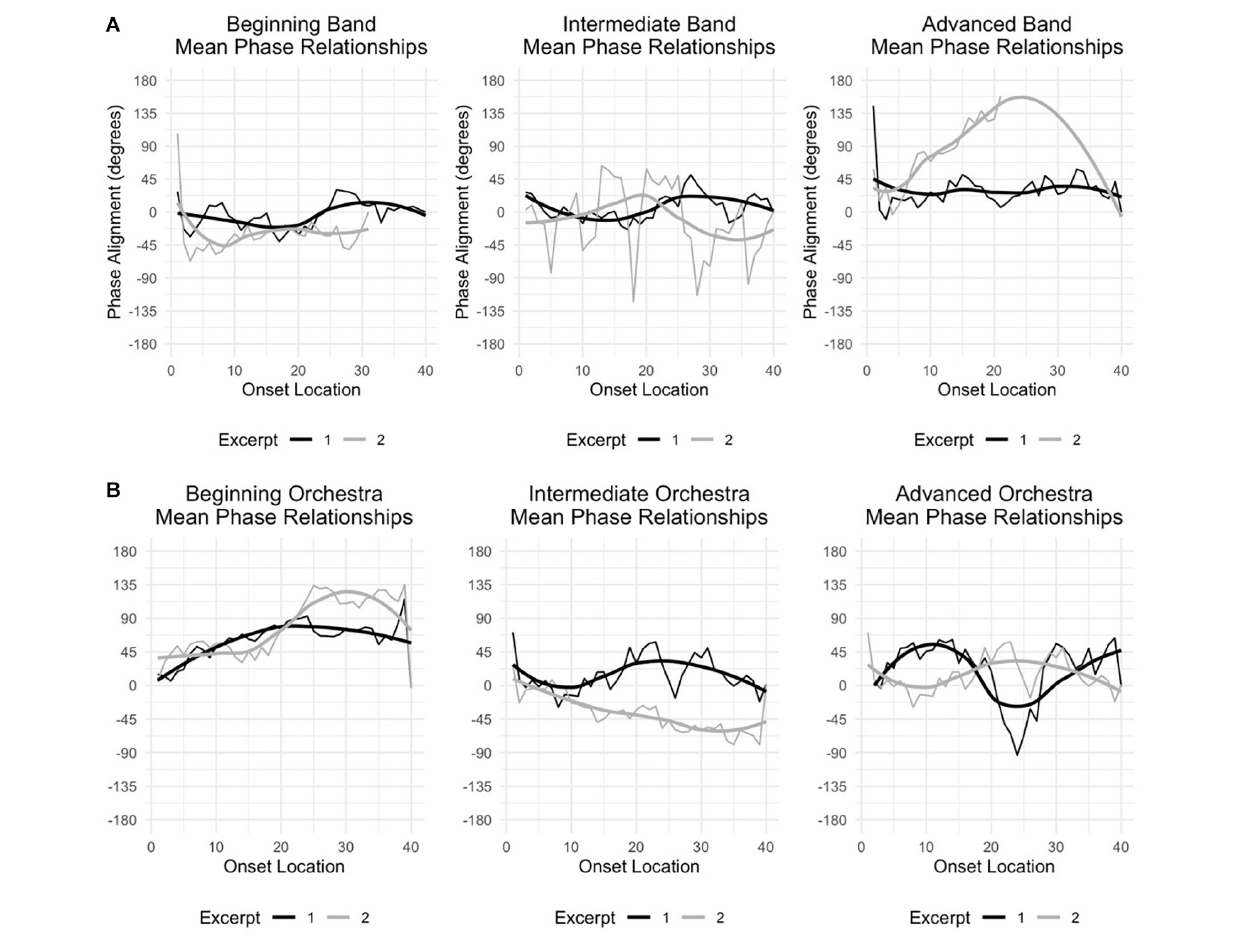
FIGURE 7 | (A) : Mean wind phase relationships by experience and excerpt. (B) : Mean orchestra phase relationships by experience and excerpt. Phase relationships illustrate the behavior of offset values over their appearance, here by ensemble and excerpt. Negative phase values indicate a sound-first or ensemble led relationship, while positive phase values indicate a sight-first or conductor-led relationship. A general tendency for wind band to vary between conductor- and ensemble-led relationships can be contrasted against a general tendency of orchestra toward a conductor-led relationship. Exceptions [e.g., Intermediate Orchestra, Excerpt 2 (Slow), Advanced Band, Excerpt 2 (Slow)] may indicate features of the ensemble’s preparation rather than generalizable features of the ensemble’s